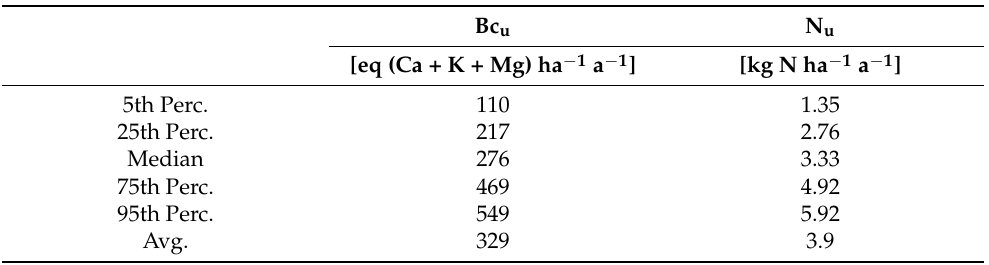
Table 11. Statistical distribution of the uptake rate of nitrogen (N u ) and base cations (BC u ) into the biomass determined for the German receptor